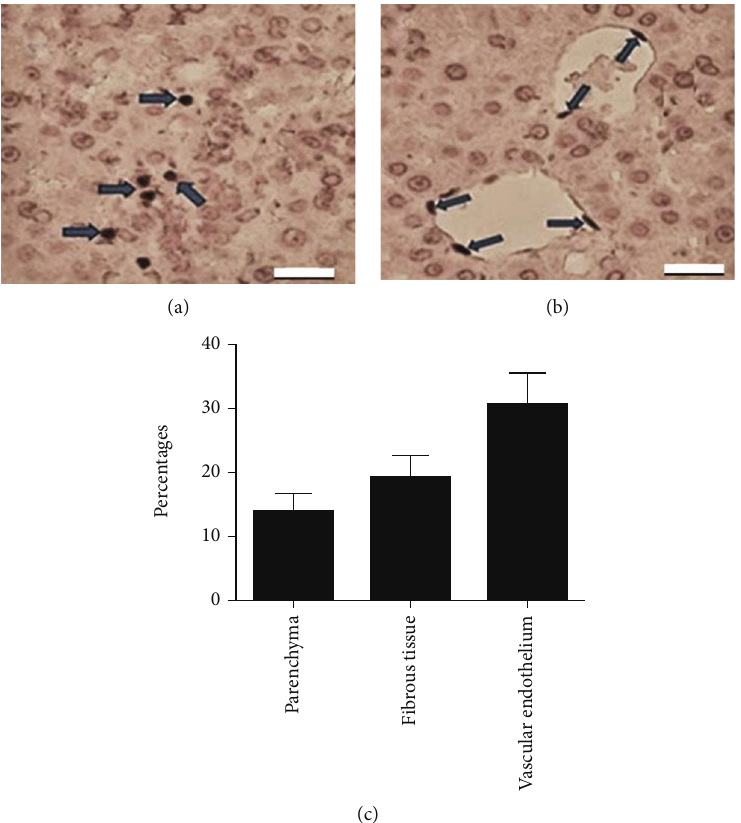
Figure 6: Adipose stem cells in di ff erent areas of the liver (blue arrows). (a) liver parenchyma. (b) endothelium, IHC. (c) Percentages of positive immunoreactivity to HuNu antibody. Bar length=50 μ m.